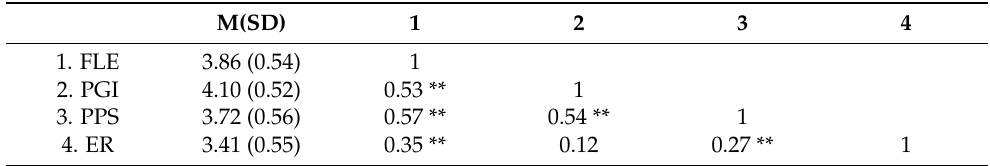
Table 1. Descriptive statistics and correlation analysis (N =